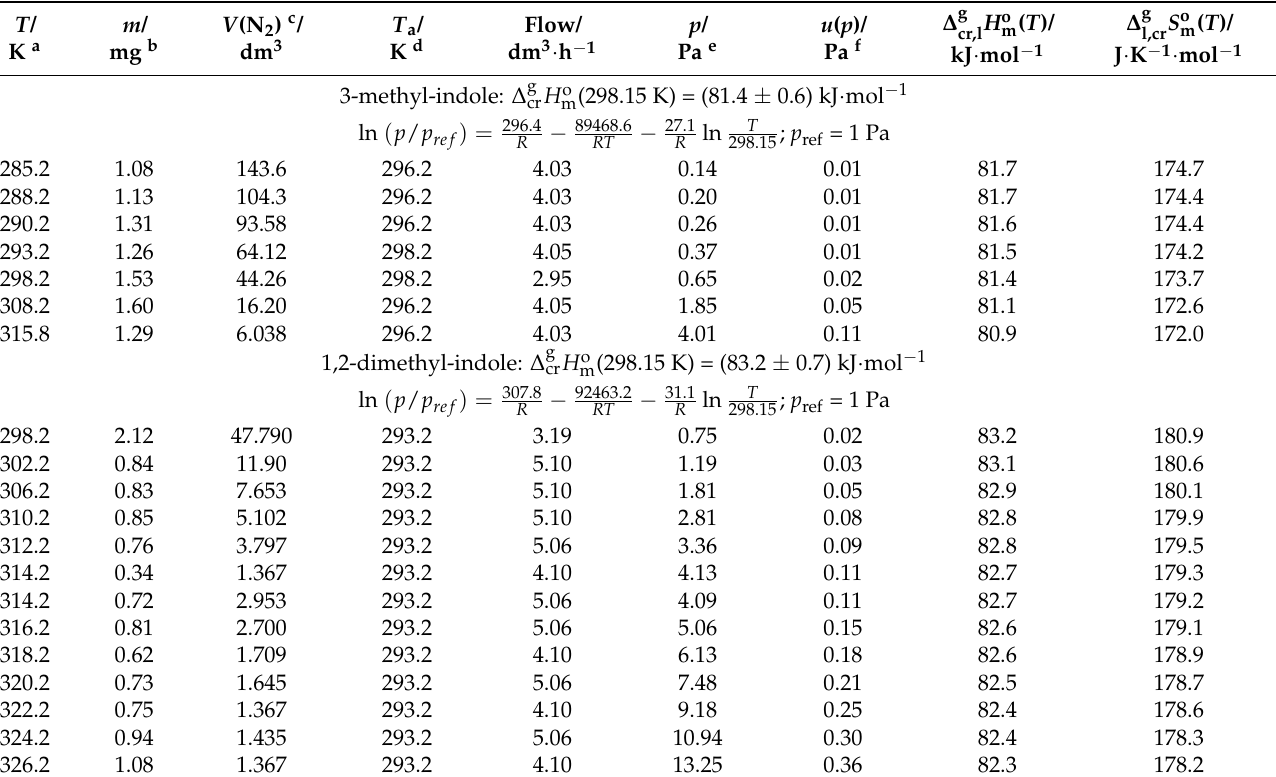
Table 4. Results of transpiration method for methyl-indole derivatives: absolute vapor pres- sures p , standard molar sublimation/vaporization enthalpies and standard molar sublima- tion/vaporization